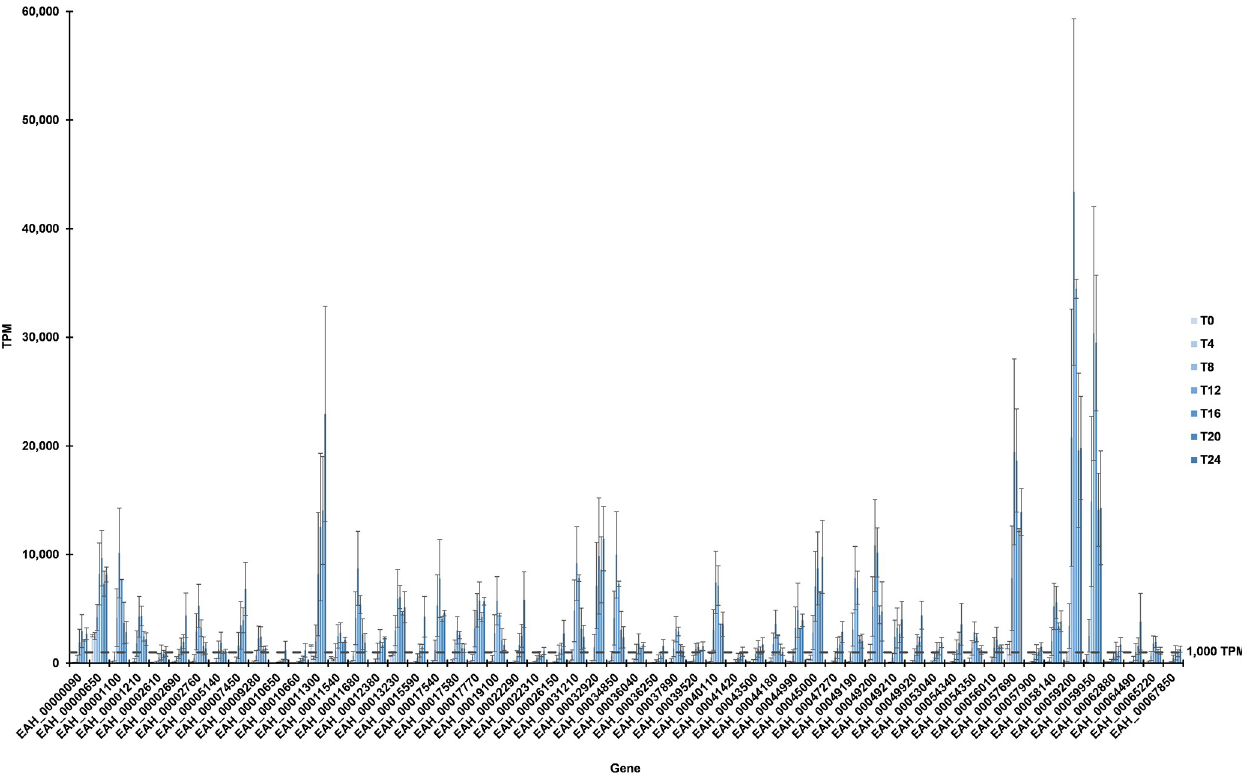
Fig 8. Significantly up-regulated genes in mature oocysts. Fifty-six genes contributed at least 1,000 transcripts per million at hour 24 and were transcribed more at hour 24 than at hour 0 (using > 1.5 log2 fold change and adjusted p < 0.05 as threshold criteria).